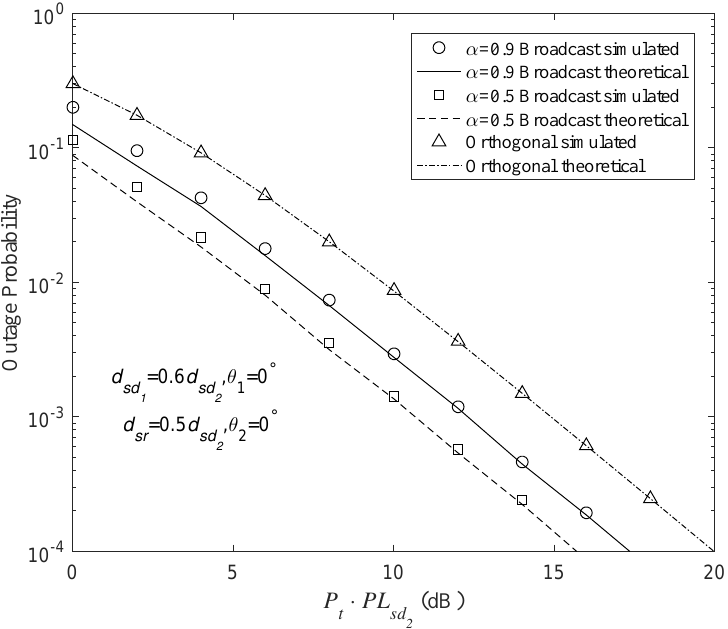
Figure 7. Outage probability of different AF protocols at N d ( τ 1 = τ 2 = 2 b/s/Hz for the orthogonal multiplexing), and transmit powers P r = P s